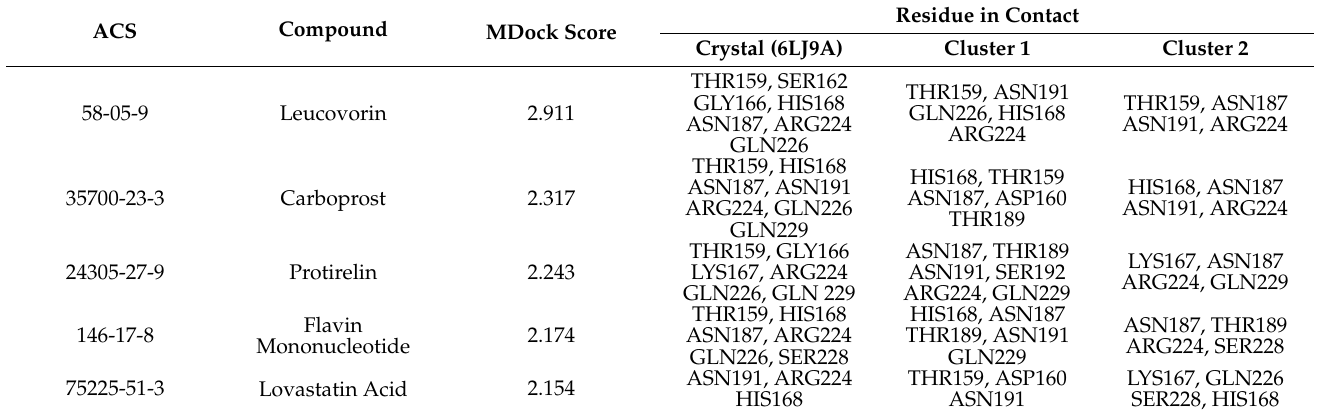
Table 2. ACS numbers, names, and MDock scores of candidate compounds and their interacting residues with Crystal (6LJ9A), Cluster 1, and Cluster 2.